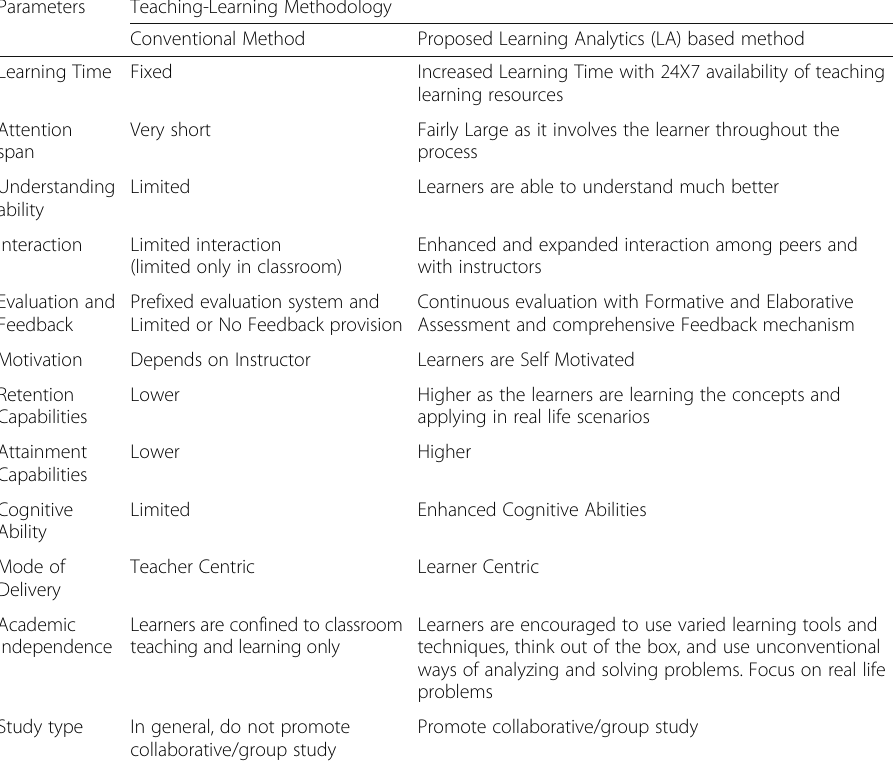
Table 1 Comparison of Conventional and Learning Analytics (LA) based Teaching-Learning Methodologies (LeCun et al., 2015; Warburton, 2003; Luna Scott, 2015; Gul et al., 2017; Chotitham et al., 2014; Nouby & Alkhazali, 2017; Rodriguez, 2009; VanderArk & Schneider,